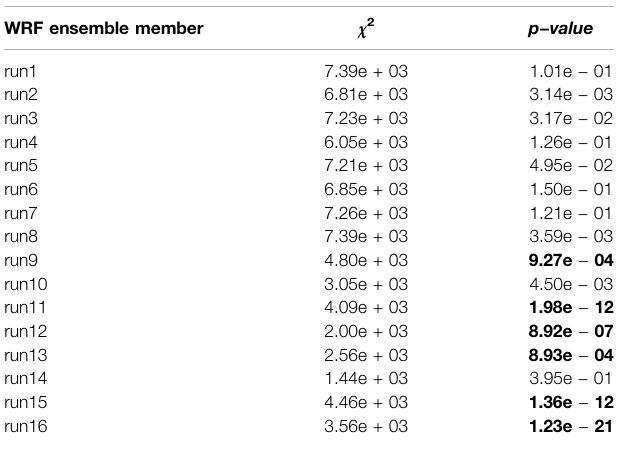
TABLE 4 | χ 2 -values and p -values of the χ 2 -tests for the 16 parameterization runs (2006 – 2010). Values < 1.0 e − 03 are bolded. WRF ensemble